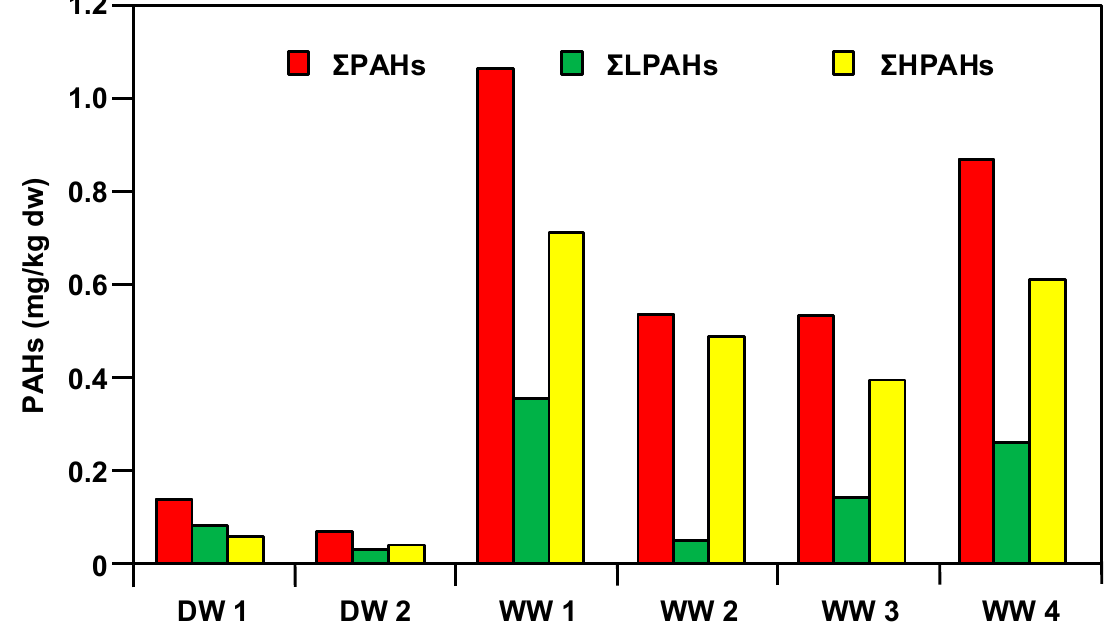
Figure 2. Distributions of Σ PAHs, Σ LPAHs, and Σ HPAHs in sludge samples of selected DWTP (DW1–DW2) and WWTP (WW1–WW4). Table 5. Compare the concentrations and composition of PAHs in sludge from other studies around the world.